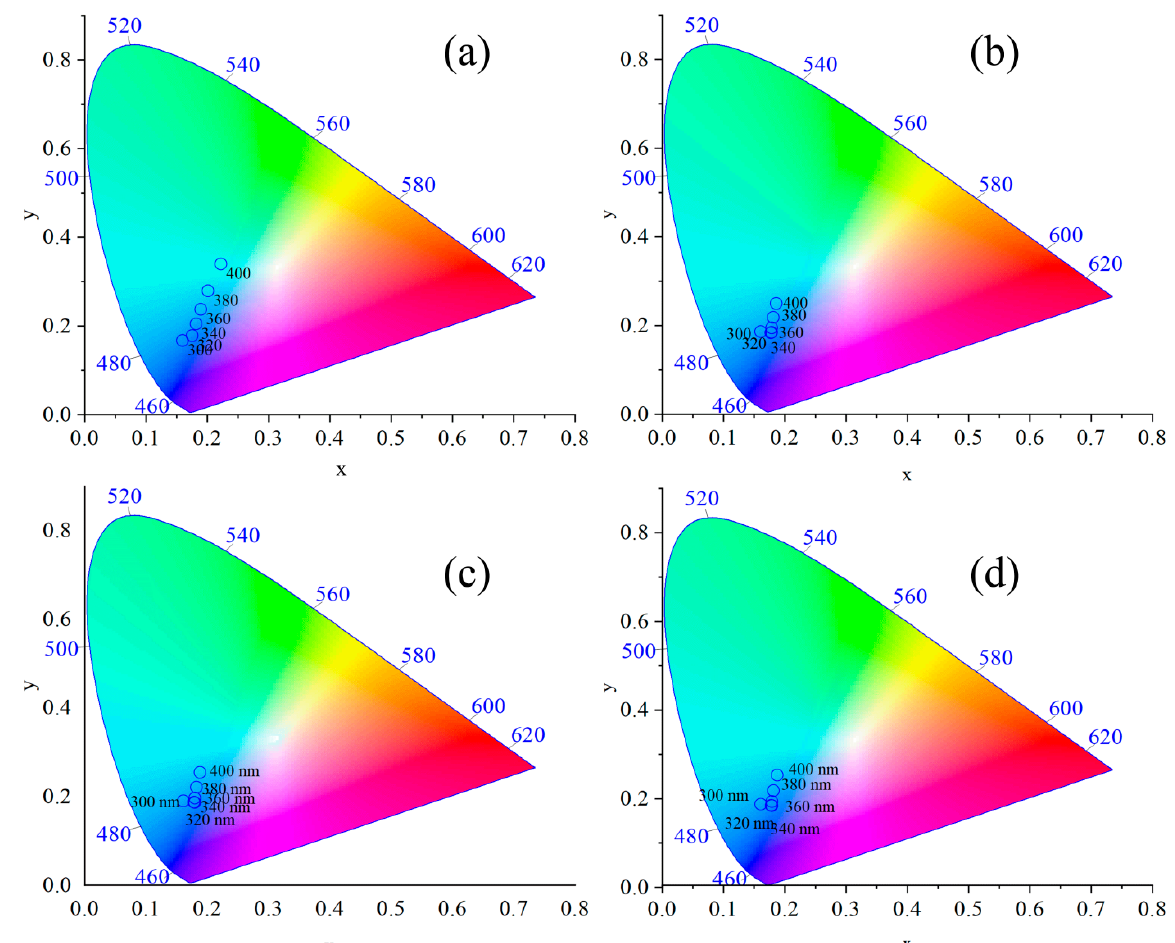
Figure 9. CIE 1931 chromaticity diagrams of p-GQDs ( a ), GQDs-200-EDA/1 g ( b ), GQDs-EDA/5 g ( c ), and GQDs-EDA/10 g ( d ).